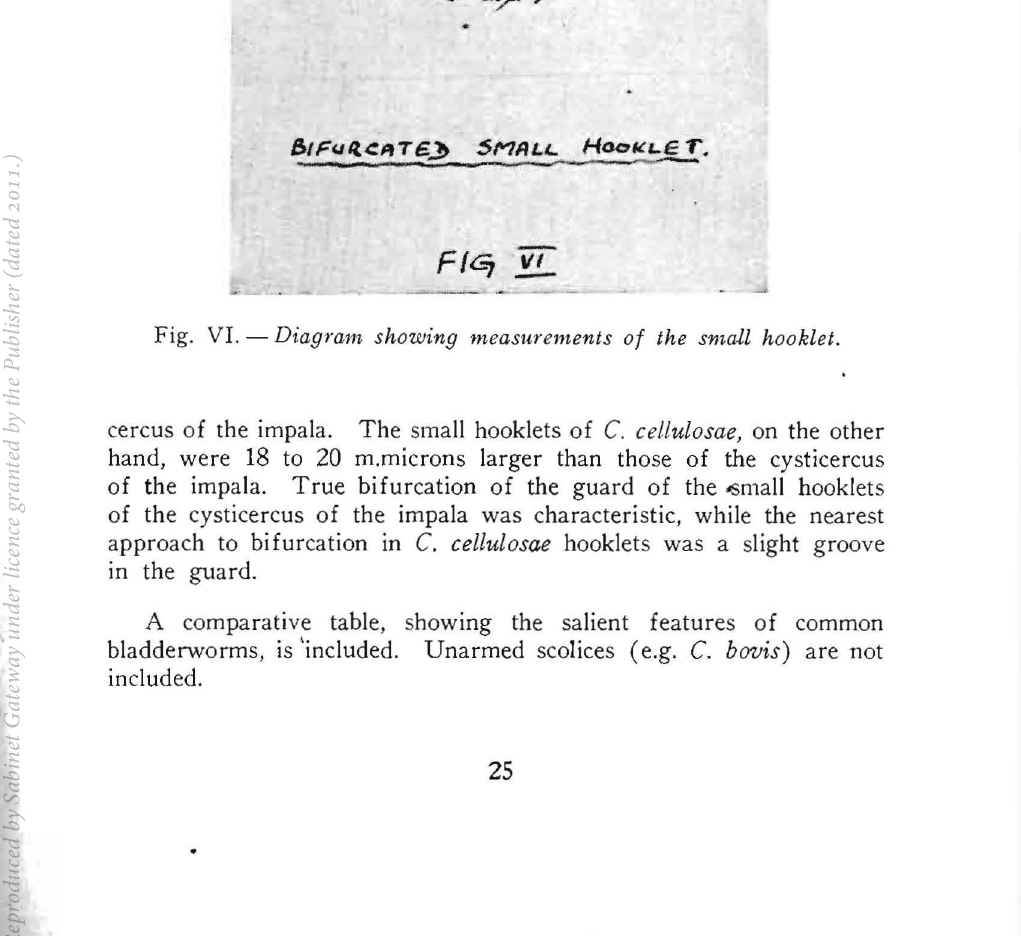
Fig. VI. - Diag1'am showing measw'ements of the small hooklet.